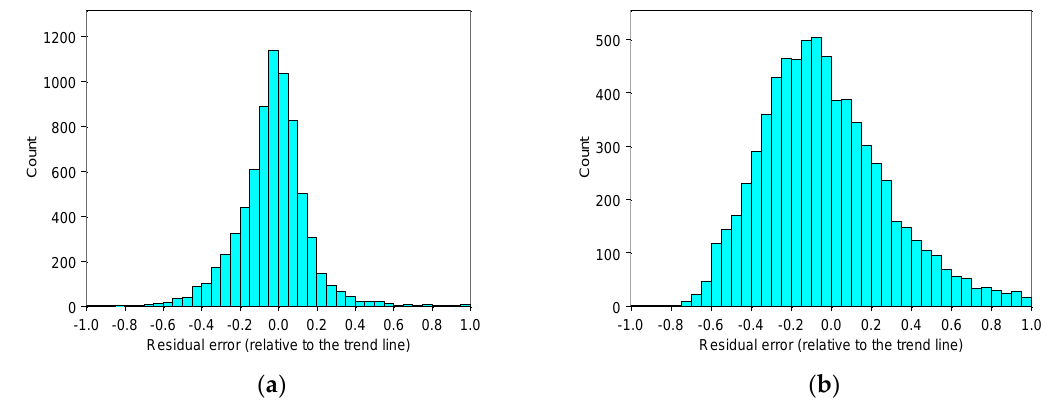
Figure 9. Histogram of the residual errors of the measured atmospheric parameters from the trend line (relative to the values in the trend line): ( a ) Aerosol density; ( b ) Water precipitation.